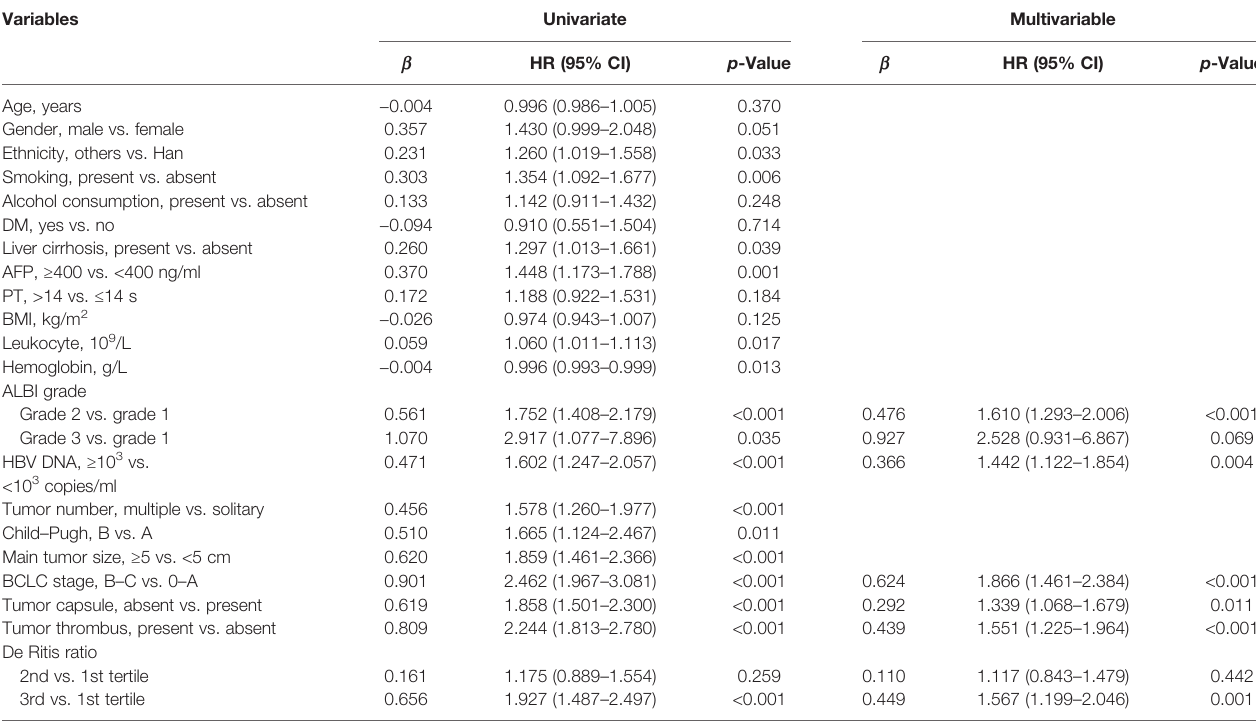
TABLE 2 | Univariable and multivariable Cox regression analyses of factors associated with OS in study patients (N = 1,147). Variables